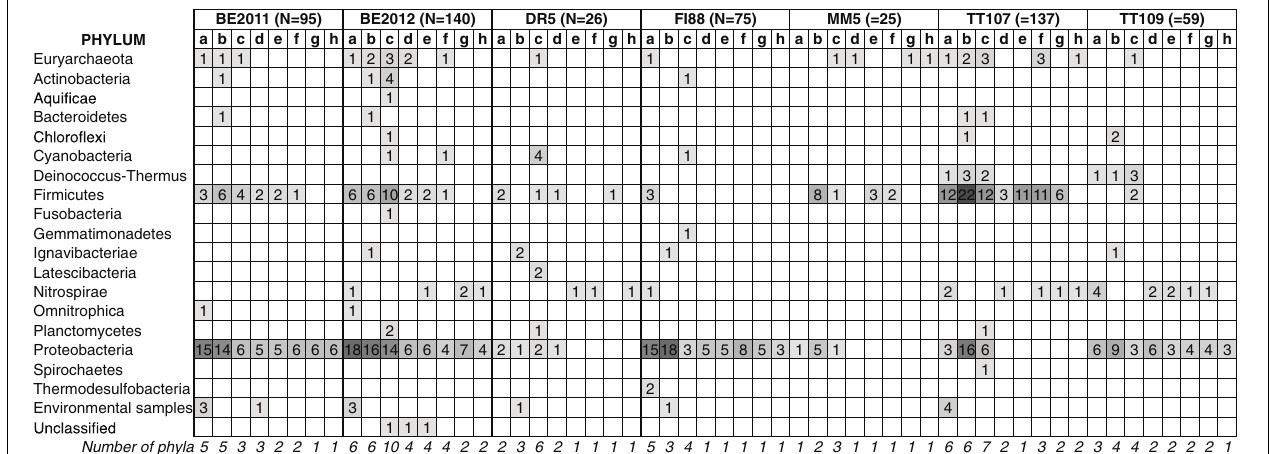
by letters: a: Nar V gene; b: NPD gene; c: PAPS reductase gene; d: Nif H gene; e: Nif D gene; f: Nif K gene; g: Nif E gene; h: Nif N gene. Sequence counts were also overlain with scaled color intensity for visual effect. The last row gives the number of phyla represented by each common functional gene.